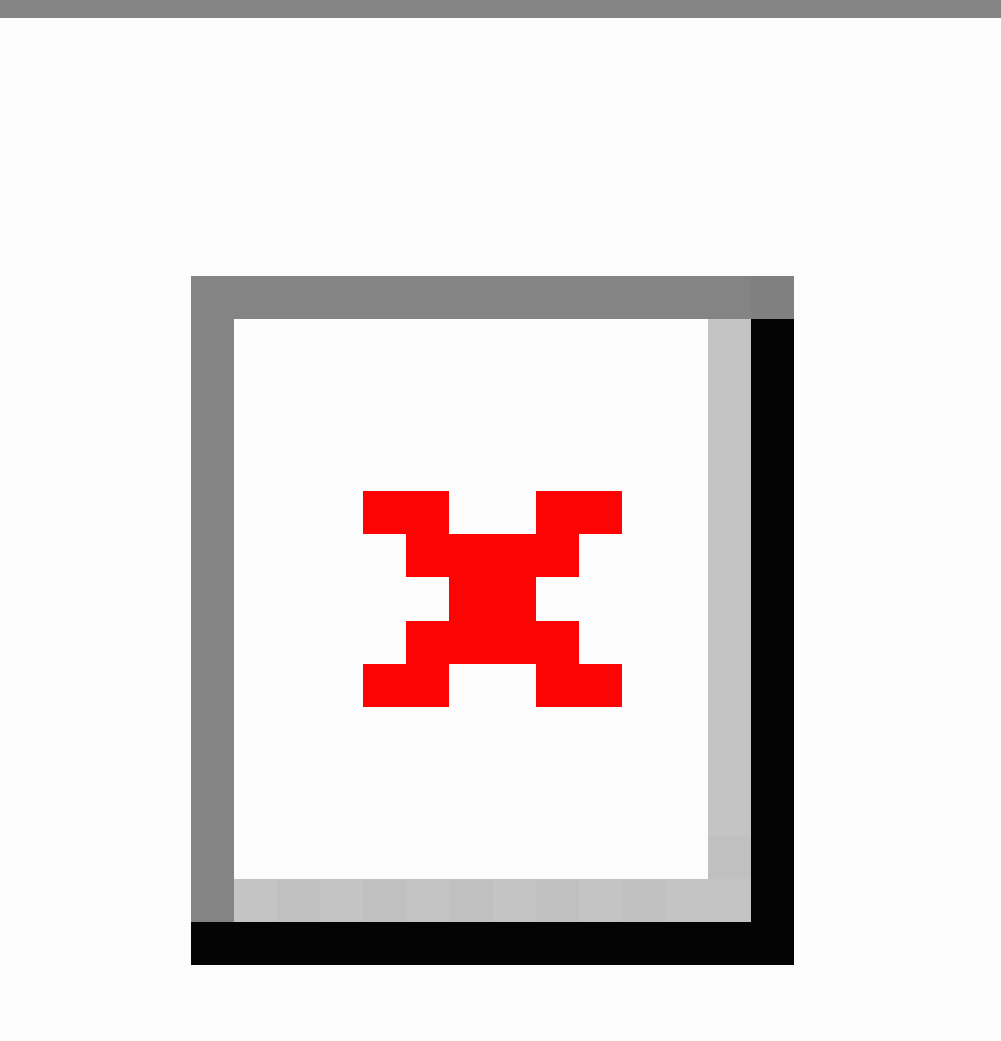
Figure 3. Bland-Altman plots comparing electronic diet entry by participants to dietitian entry of 3-day diet record (DR) into Grand Forks Research Analysis of Nutrient Data (GRAND). Plots for energy and macronutrients comparing Nutrihand and Tap & Track to GRAND. Solid horizontal line indicates mean of differences between Nutrihand or Tap & Track and GRAND. Upper and lower limits of agreement (dashed lines) define range within which most differences between methods are expected to occur. Dotted line at y=0 is given for